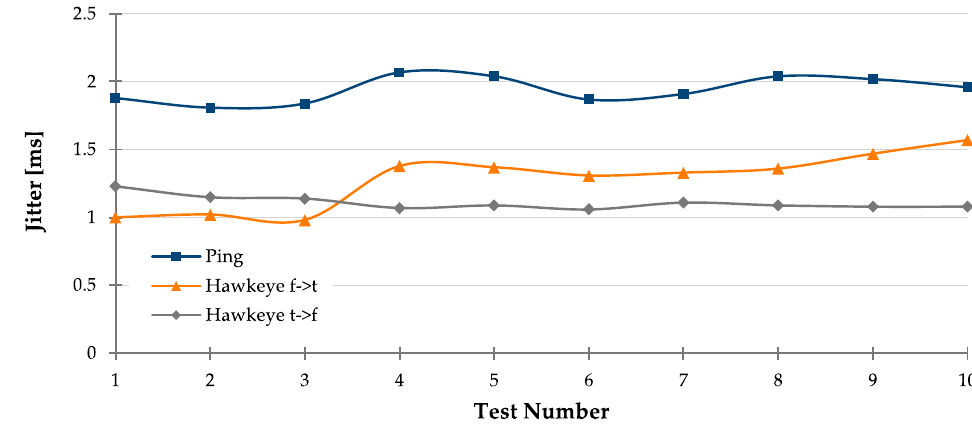
Figure 6. Jitter measurements with ping and Hawkeye tests for D2D communication in 5G-NSA.